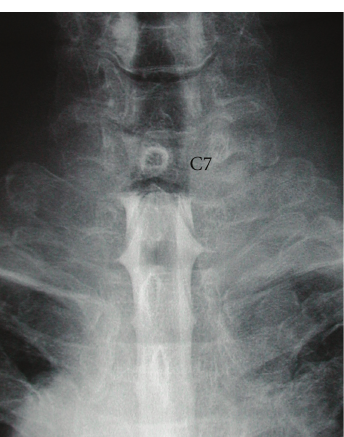
Figure 2: MRI on T2-weighted image.